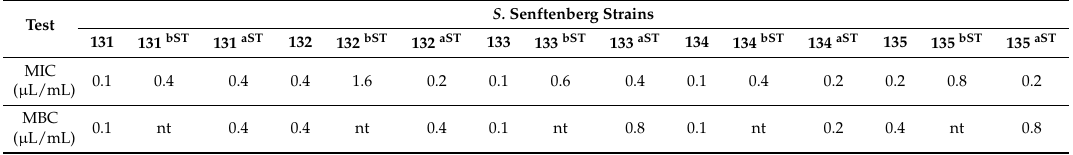
Table 2. MIC and MBC values of the triamine-containing disinfectant for Salmonella Senftenberg strains.